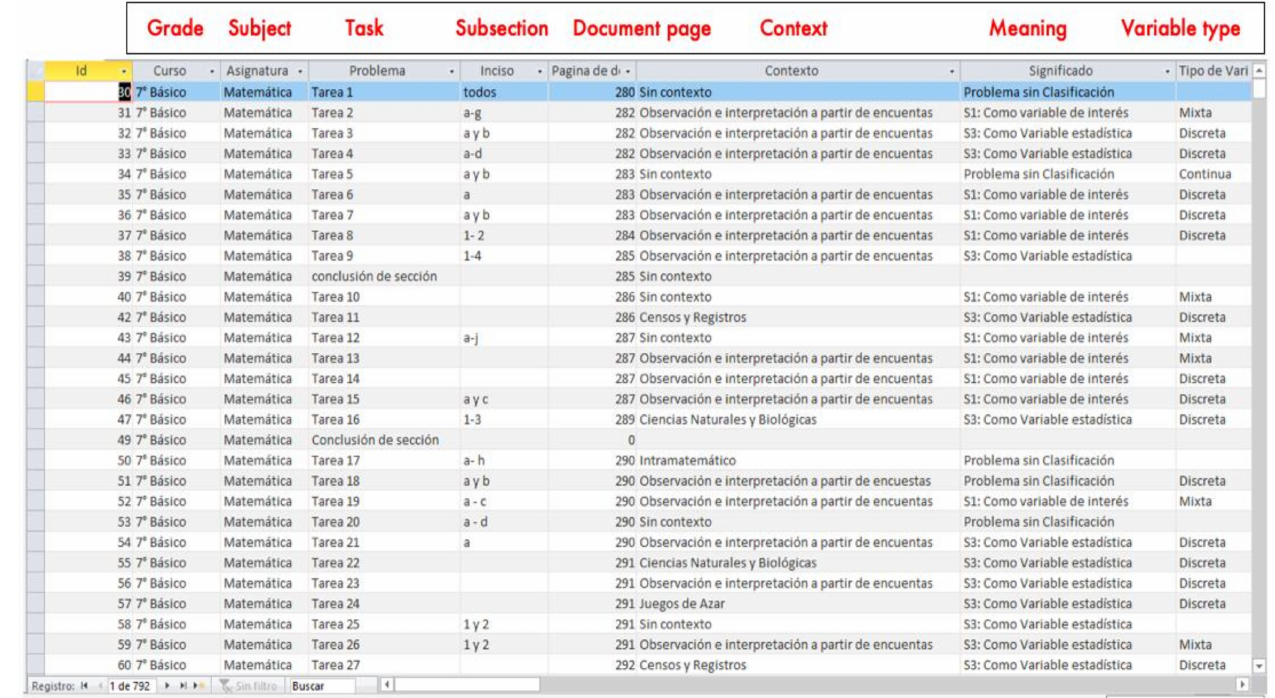
Figure 4. Database with analysis records (Source: Prepared by the